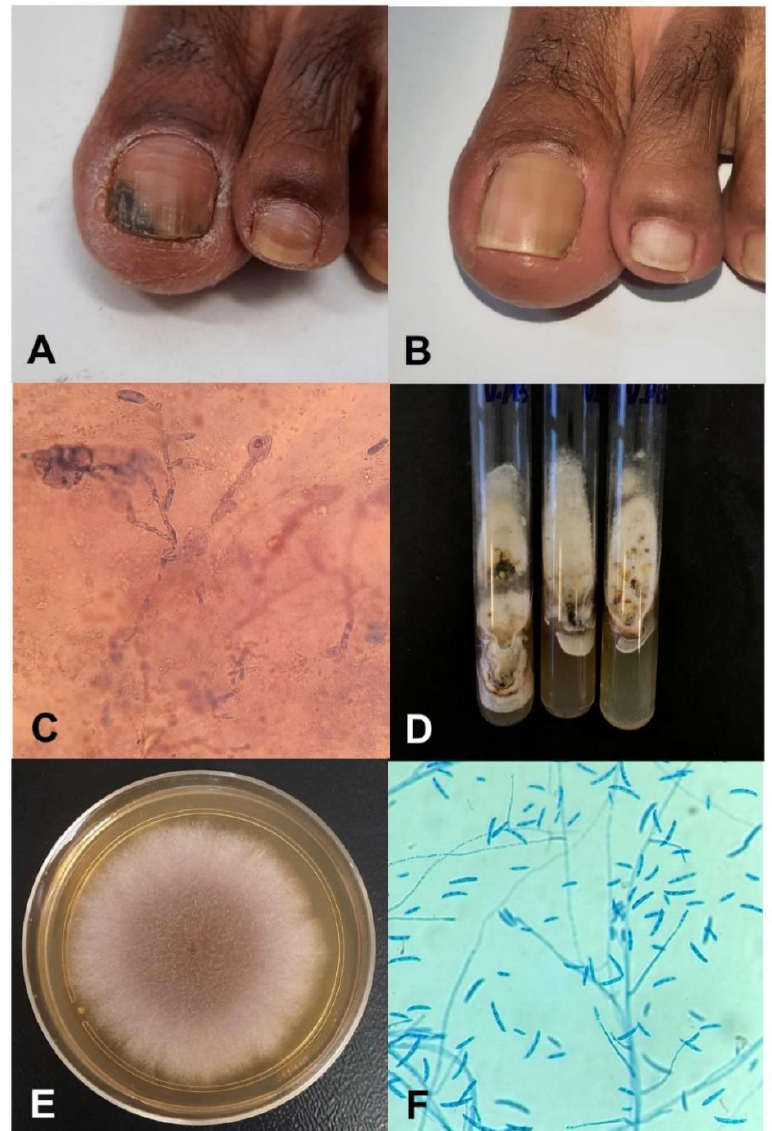
Figure 1. Clinical and laboratory characteristics of a case of onychomycosis due to Neocosmospora keratoplastica topically treated with propolis gel for 12 months. ( A ) Clinical nail aspects before treatment; ( B ) after treatment; ( C ) fungal structures observed with direct microscopy after clarification with KOH plus Evans. ( D ) development in Sabouraud dextrose agar after four days of incubation at 25 ◦ C; ( E ) macro- and ( F ) micromorphological aspects of the grown